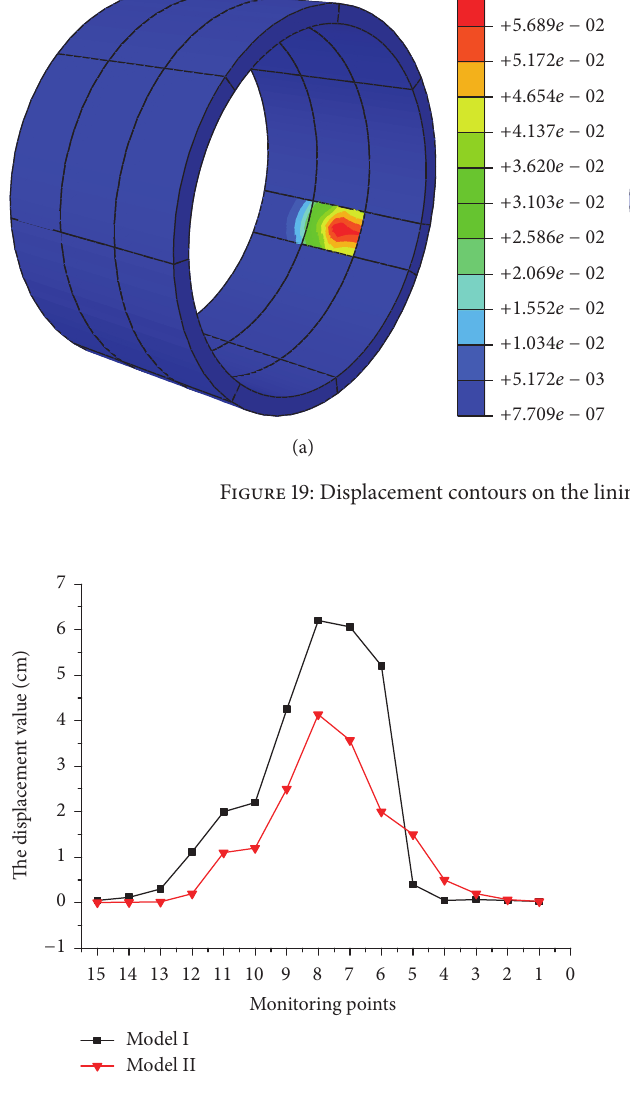
6.20 ms, and 5.41 ms, respectively. Compared with the case of 200 km/h, the average failure times in the cases of 250 km/h and 300 km/h are 0.66 ms and 1.45 ms shorter,